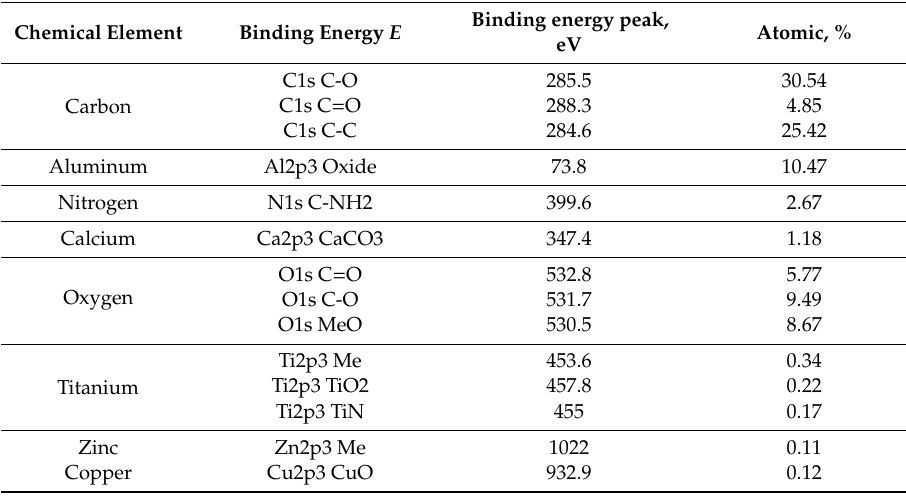
Table 5. X-ray peaks of the machined Al 2 O 3 + 30%TiC nanocomposite in